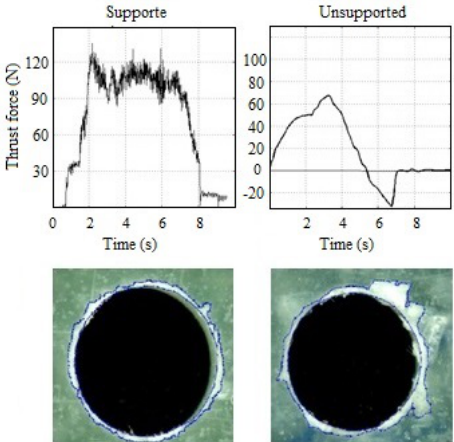
Figure 4. The graphs of thrust force and the scanned images of delamination in drilling with and without support plate.